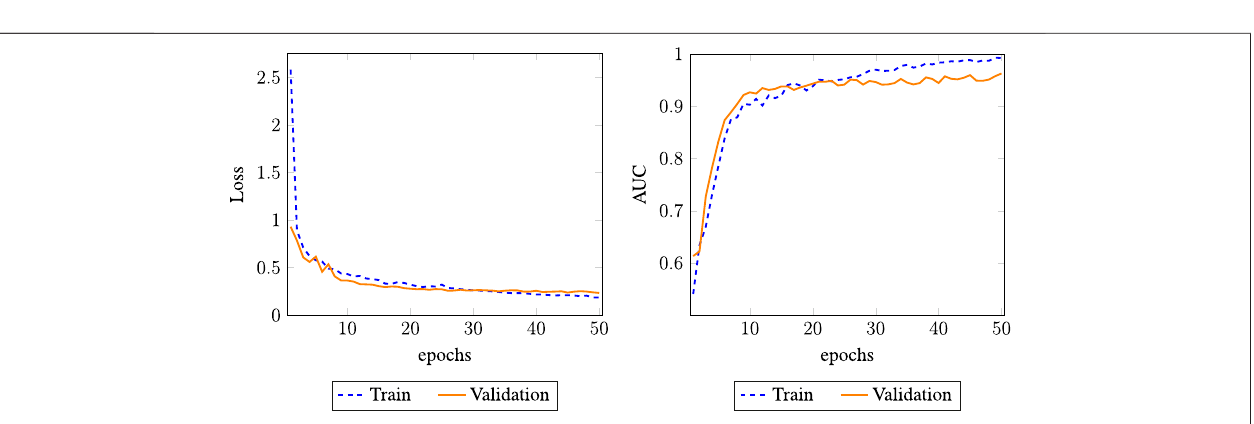
Frontiers in Pharmacology |